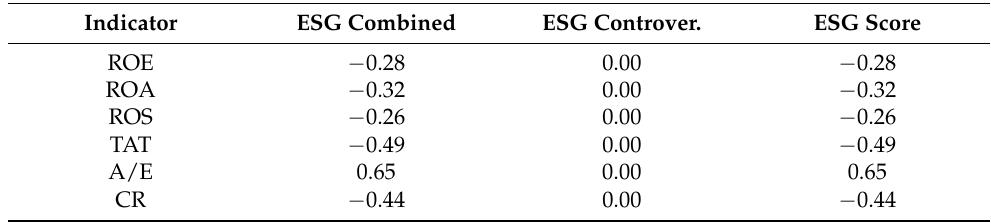
Table 10. Correlations between values of indicators taken into account in research in the case of the enterprise Tauron Polska Energia S.A. (period of